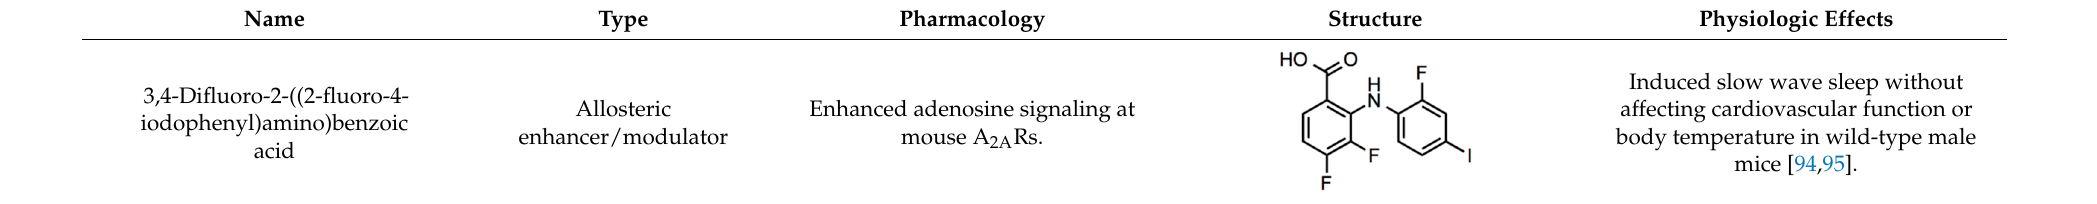
Table 1. Allosteric A 2A R modulators and their functions.